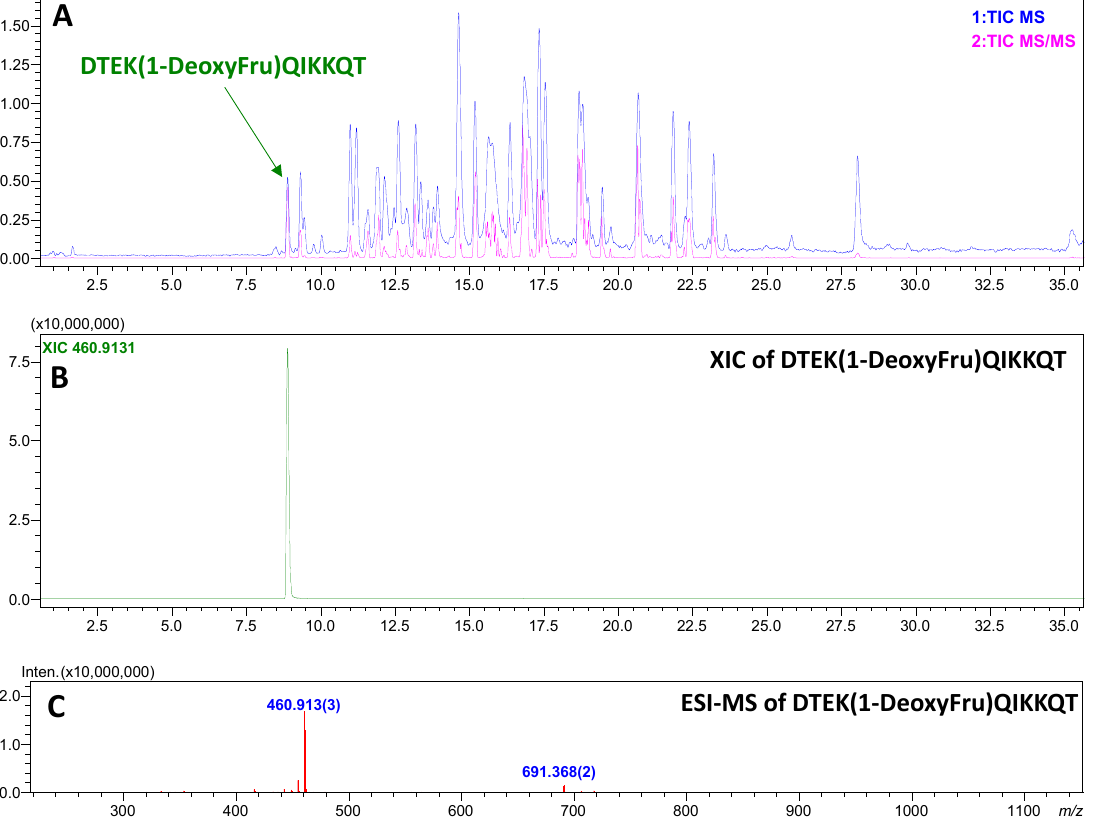
Figure 2. Analytical characterisation before performing the capturing procedure of the hydrolysate of Bovine Serum Albumin (500 pmol, BSA, BioLabs) with the deoxyfructosylated peptide DTEK(1-DeoxyFru)QIKKQT ( 18 ) (300 pmol). Panel ( A ): Total Ion Chromatogram. Panel ( B ): Extracted Ion Chromatogram. Panel ( C ): ESI-MS.